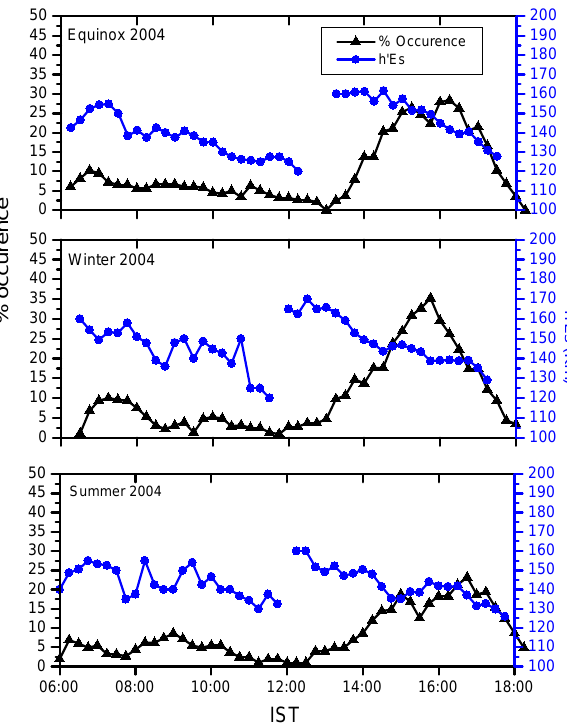
Fig. 3. Occurrence probability of the intermediate layers (black line) and their virtual heights, h’Es (blue line) during 2004 at Wal-